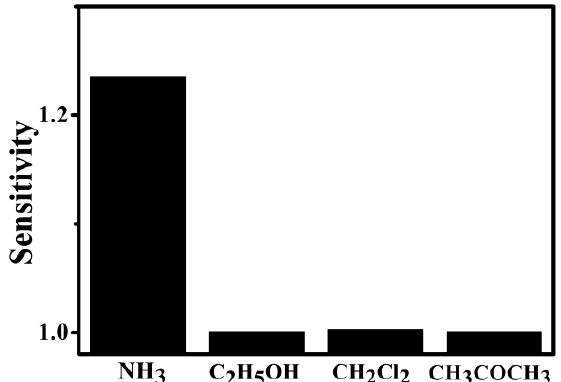
Figure 6. Selectivity of PPy–PAN nanofiber yarn sensor. Concentration of the gas is 500 ppm. (The concentration of p -toluenesulfonic acid ( p -TSA) was 0.004 M).